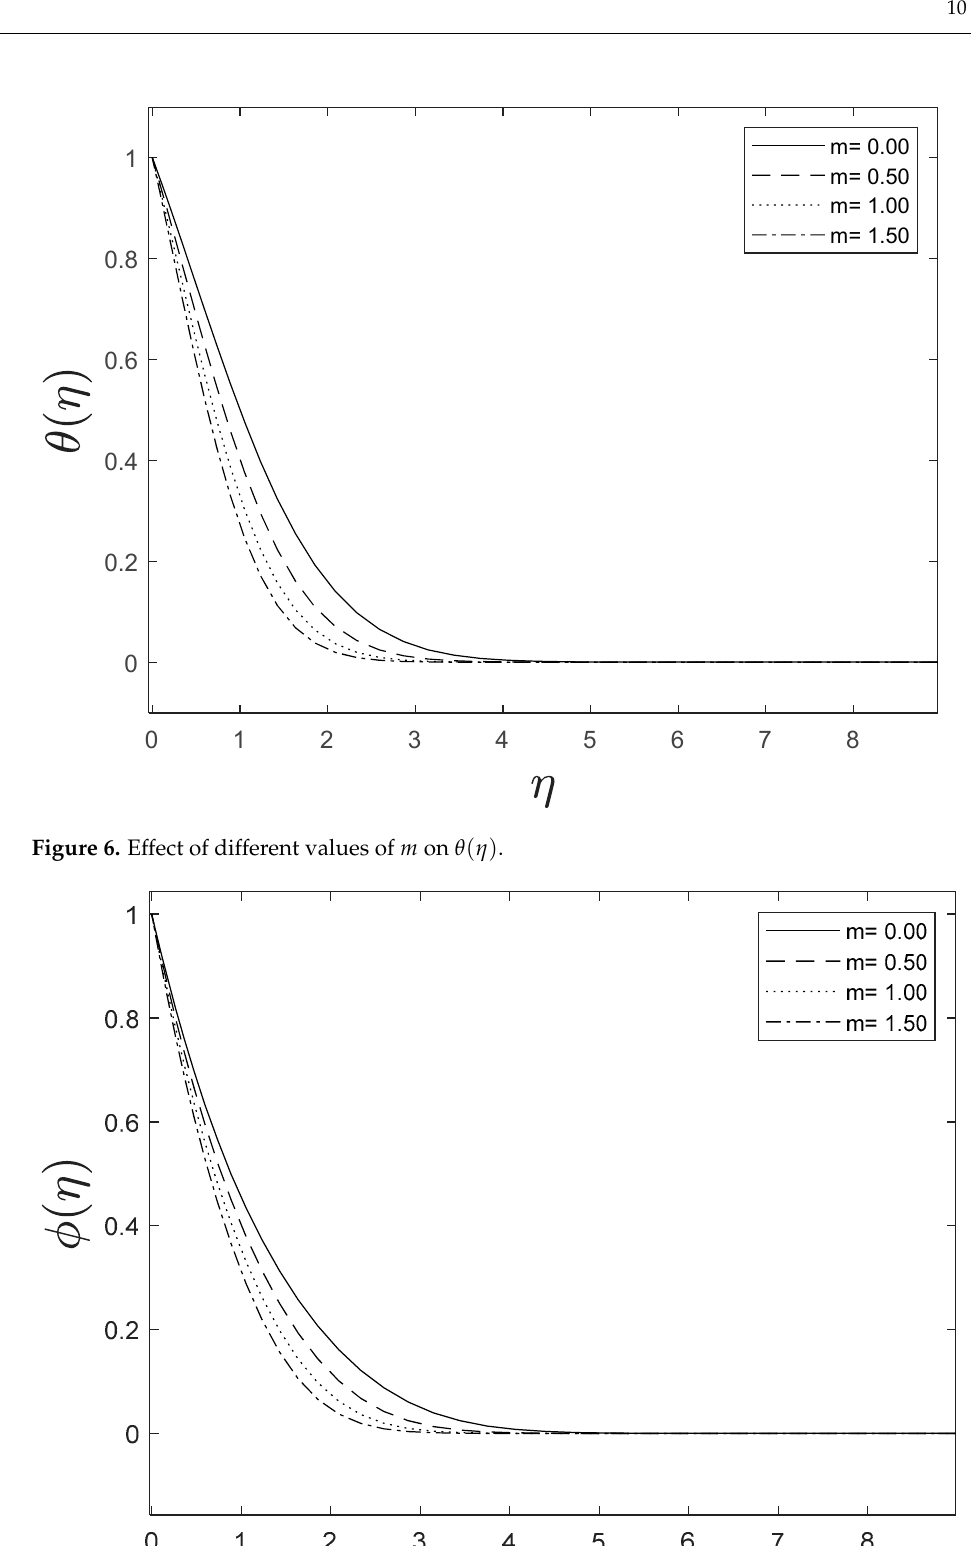
Figure 7. Effect of different values of m on φ ( η ) . Fluid velocity amplifies as the velocity ratio parameter V grows, whereas fluid temperature and concentration drop as the velocity ratio parameter boosts. This is observed in Figures 8–10.